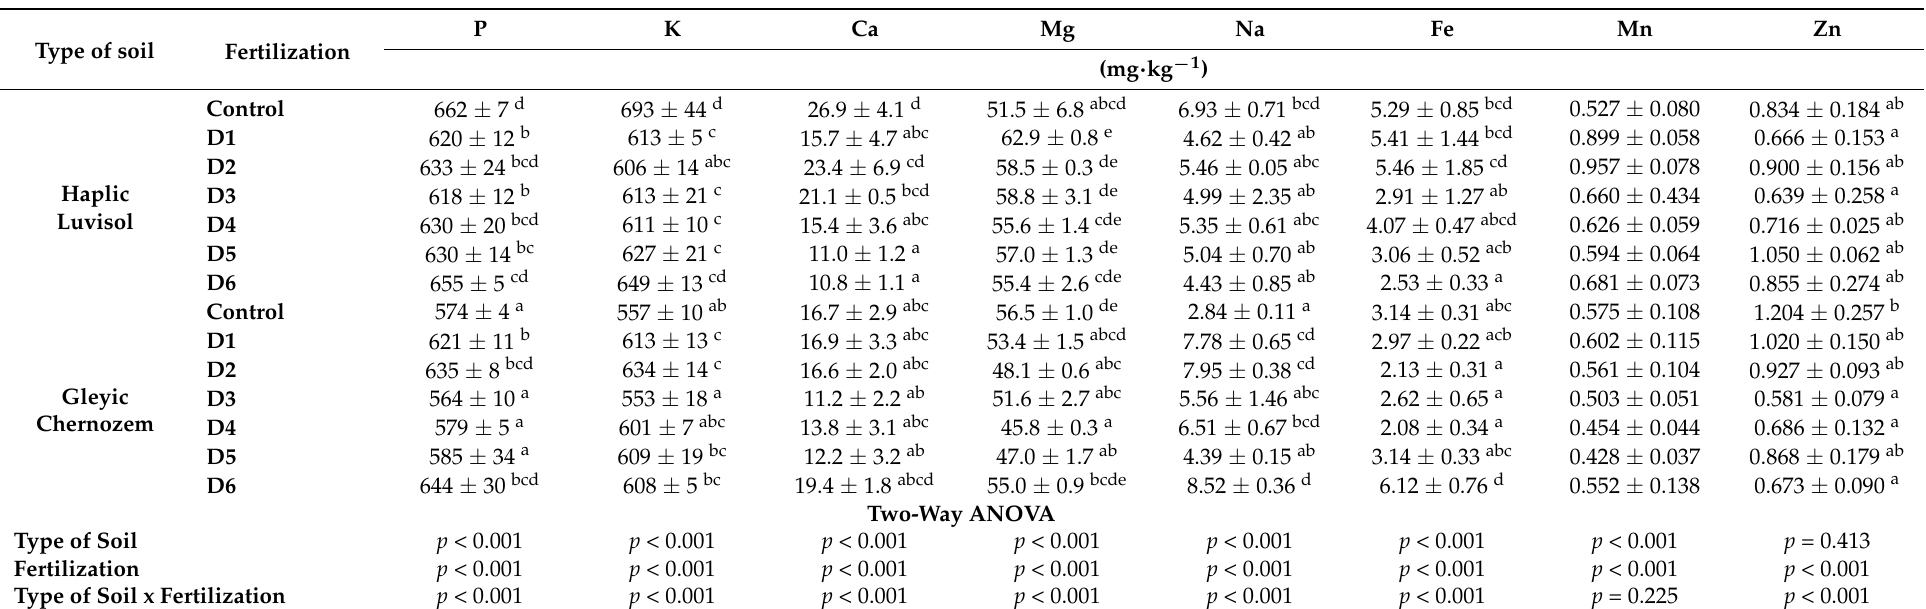
Table 2. The content of macronutrients and micronutrients in potato starch depending on the type of soil and application of ash fertilizer derived from biomass